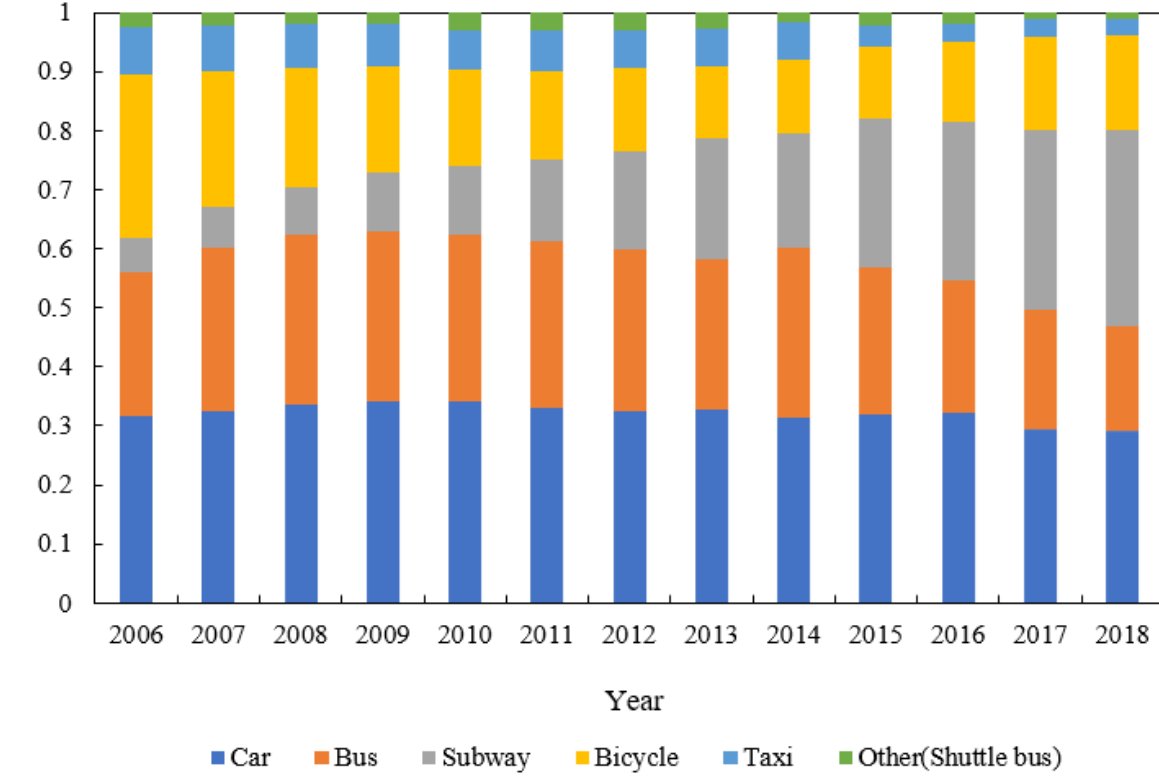
Figure 6. Changes in transport travel structure in Beijing from 2006 to 2018.